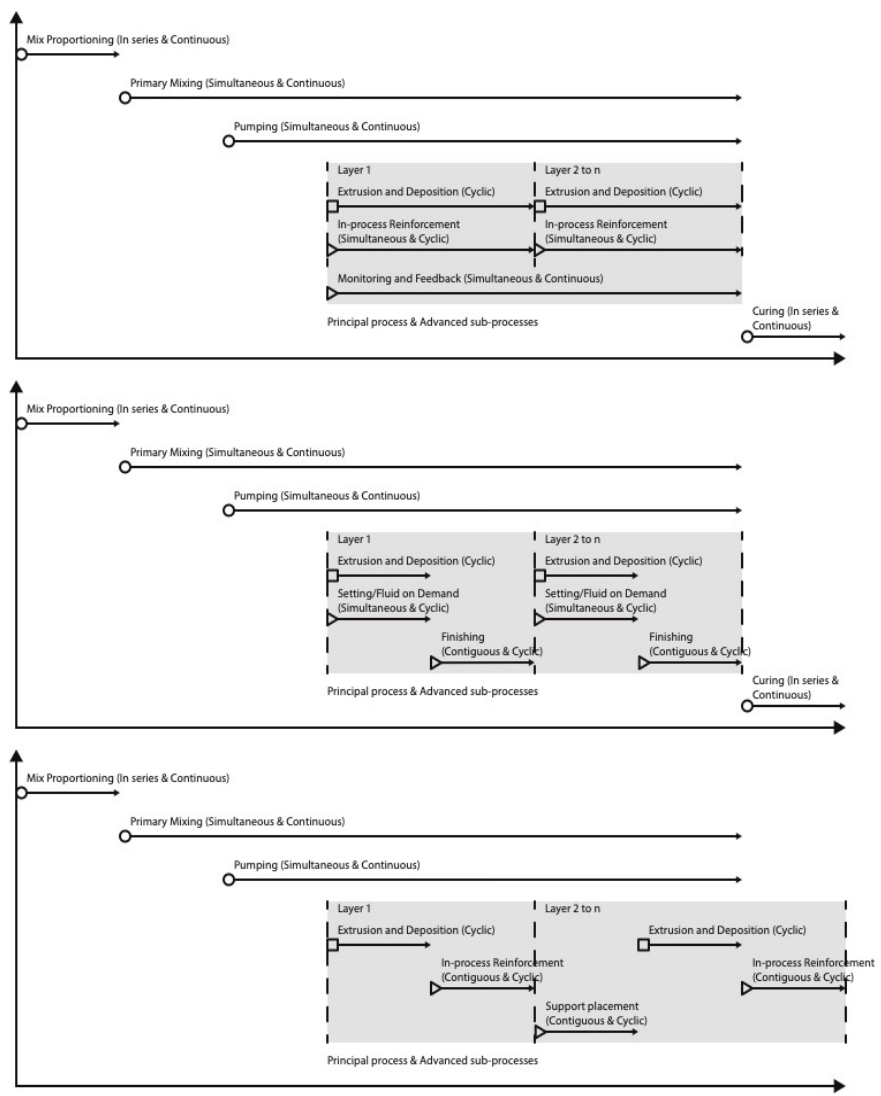
Figure 10. The process chain of three different E3DCP systems of various process combinations ac- cording to the pictorial representation method proposed by [1].